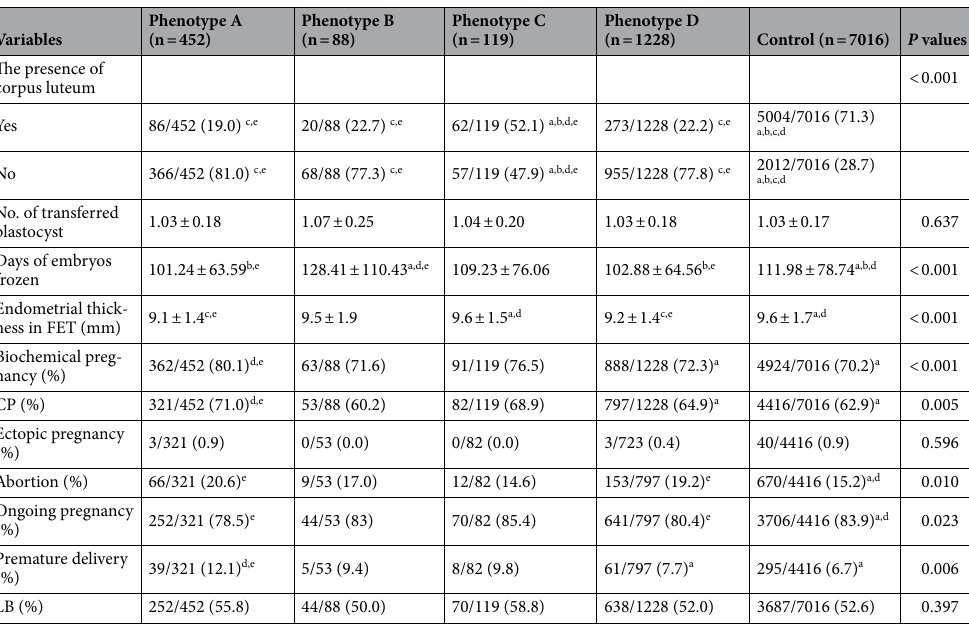
Table 2. FET cycle characteristics and pregnancy outcomes of four PCOS phenotype and control groups. The presence or absence of a corpus luteum was based on endometrial preparation protocols; that is, natural and ovulation induction cycles were considered to mean the formation of a corpus luteum, and a hormone replacement therapy cycle was regarded as meaning the absence of a corpus luteum. CP, clinical pregnancy; FET, frozen-thawed embryo transfer; LB, live birth. a P values < 0.05, compared with phenotype A. b P values < 0.05, compared with phenotype B. c P values < 0.05, compared with phenotype C. d P values < 0.05, compared with phenotype D. e P values < 0.05, compared with the control